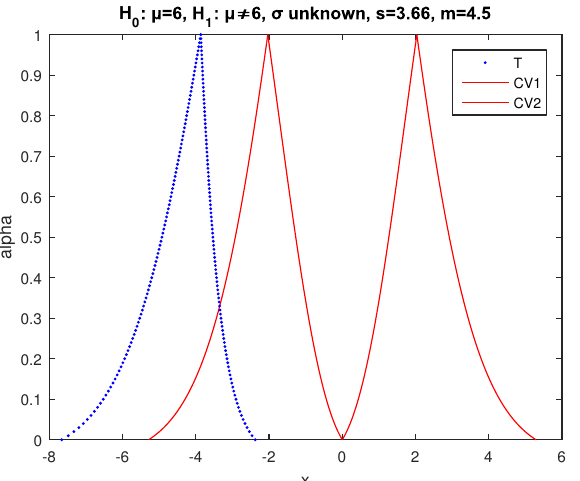
Figure 16. The fuzzy statistic T and the fuzzy critical values for the test of H 0 of [30] for Example